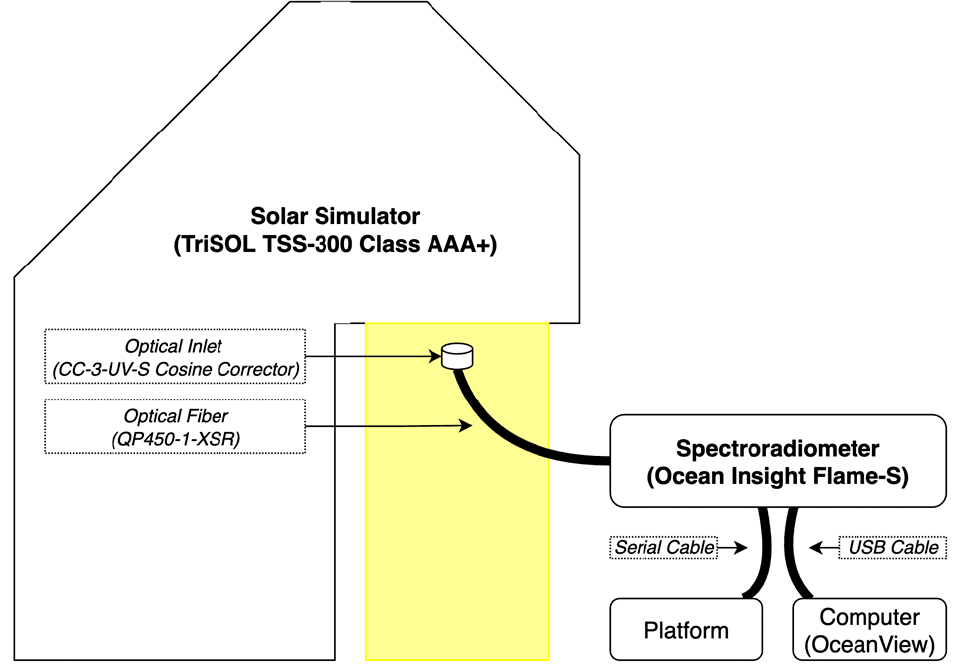
Figure 2. A simple block diagram of the testing setup.